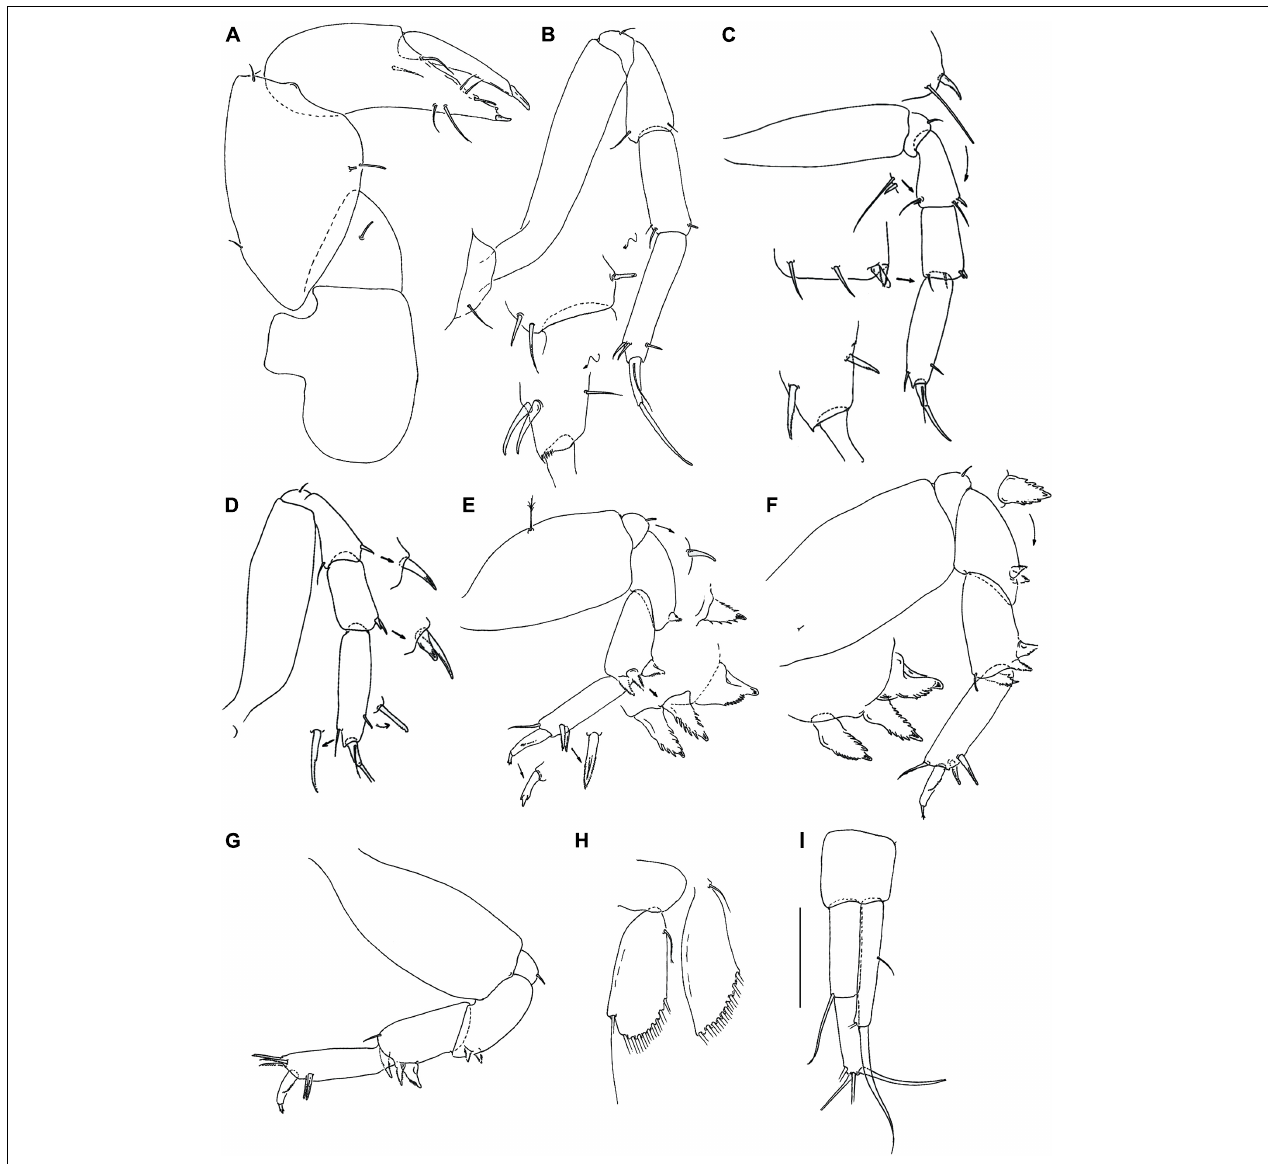
FIGURE 5 | Hamatipeda caipiroska n. sp. (MCZ 48350) (A) cheliped; (B) pereopod-1; (C) pereopod-2; (D) pereopod-3; (E) pereopod-4; (F) pereopod-5; (G) pereopod-6; (H) pleopod; (I) uropod. Scale: panels (A–I) = 0.1